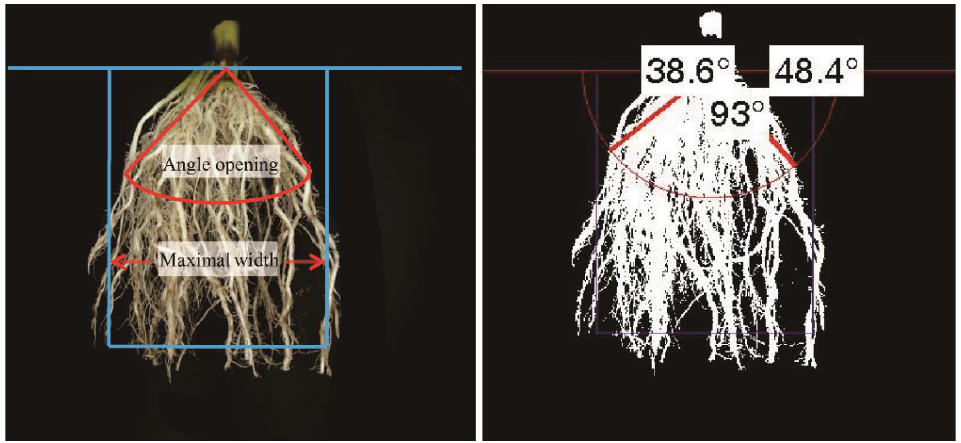
Figure 2. Root image processing with Root Estimator for Shovelomics Traits